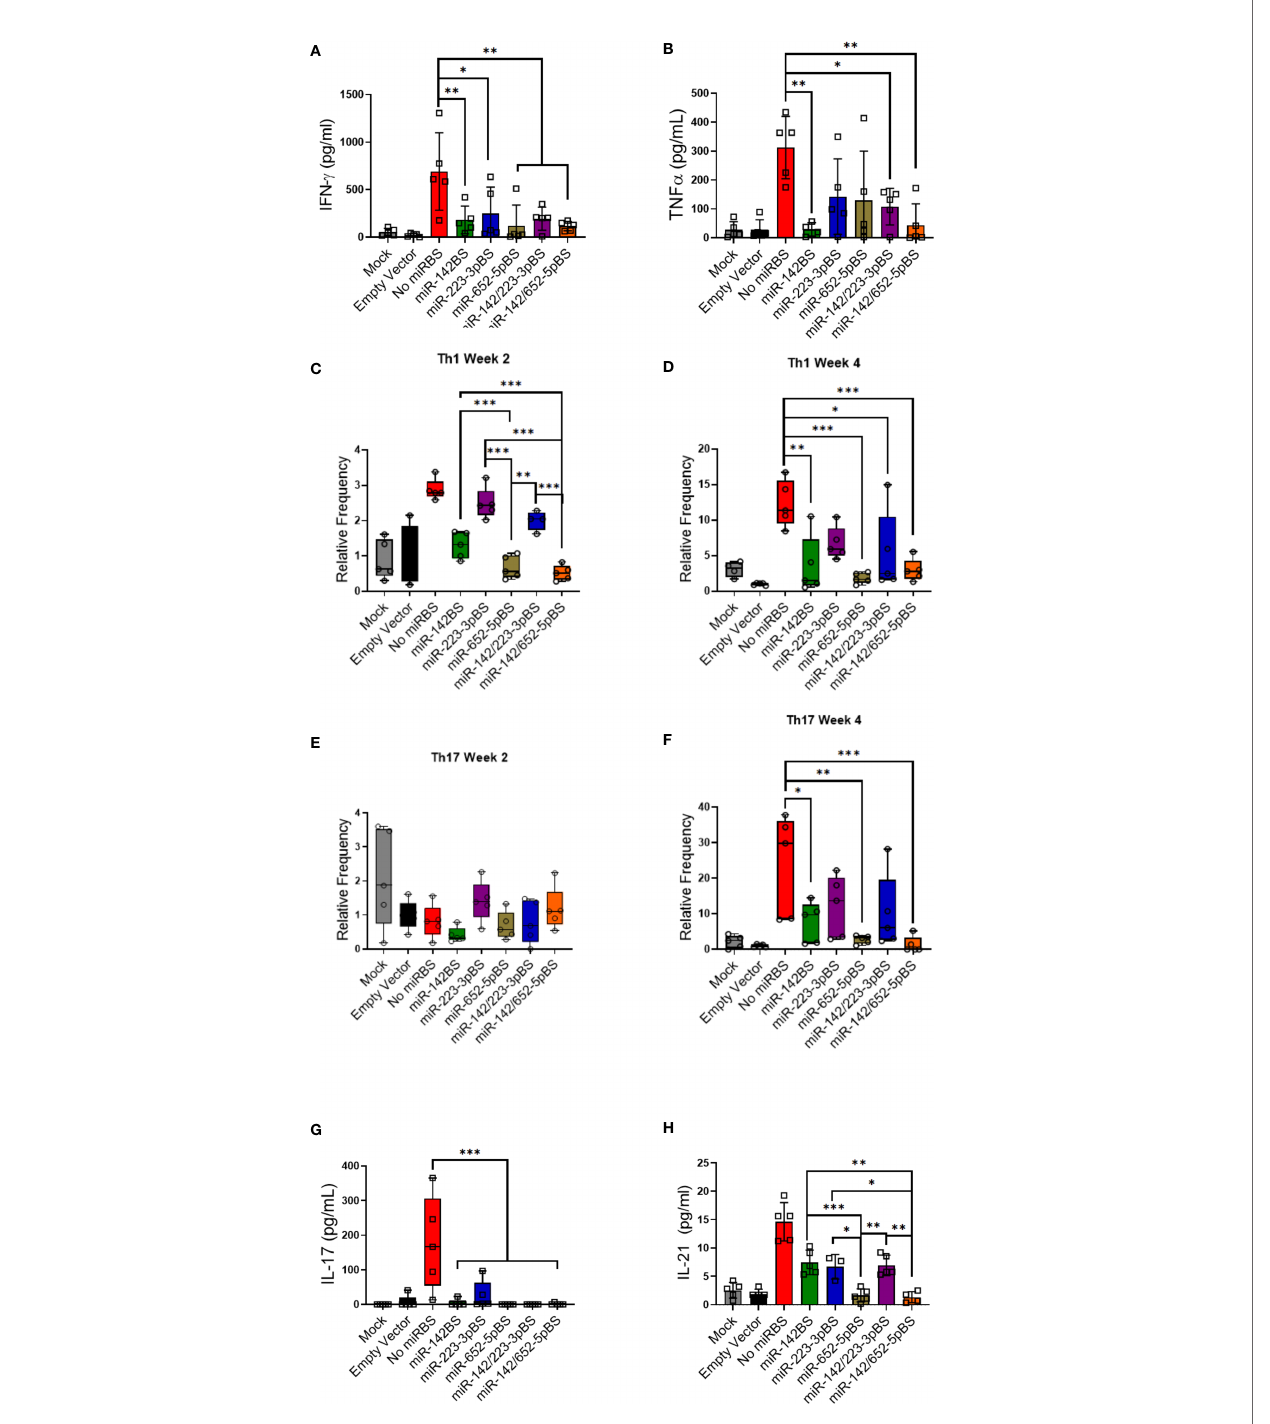
FIGURE 5 | miR-BS incorporation diminishes transgene-speci fi c Th1 and Th17 in fl ammatory responses. (A, B) Estimation of IFN- g and TNF- a response to OVA stimulation (5 m g/mL) by splenocytes isolated from mice four weeks after vector injection. Three days after treatment, supernatants were collected and quantitated by ELISA (mean ± SD, n = 5). p values were determined by ANOVA with Tukey ’ s post hoc test. Splenocytes isolated two and four weeks post-AAV1 injection were stimulated for 24 hours with OVA (5 m g/mL) and stained for detecting either Th1 population (CD4+) (C, D) or Th17 cell population (CD4+IL-17A+) (E, F) and analyzed by fl ow cytometry (Box plots with means, fi rst and third quartile boundaries, and whiskers indicating max and min values; n = 5). (E, F) Levels of secreted Th17-speci fi c cytokines, IL-17 and IL-21- were assessed after stimulation of splenocytes (harvested four weeks post-injection) for 72 hours with OVA (5 m g/mL) by ELISA (mean ± SD, n = 5). * p < 0.05, ** p < 0.01, *** p < 0.001. p values were estimated by one-way ANOVA with Tukey ’ s post hoc